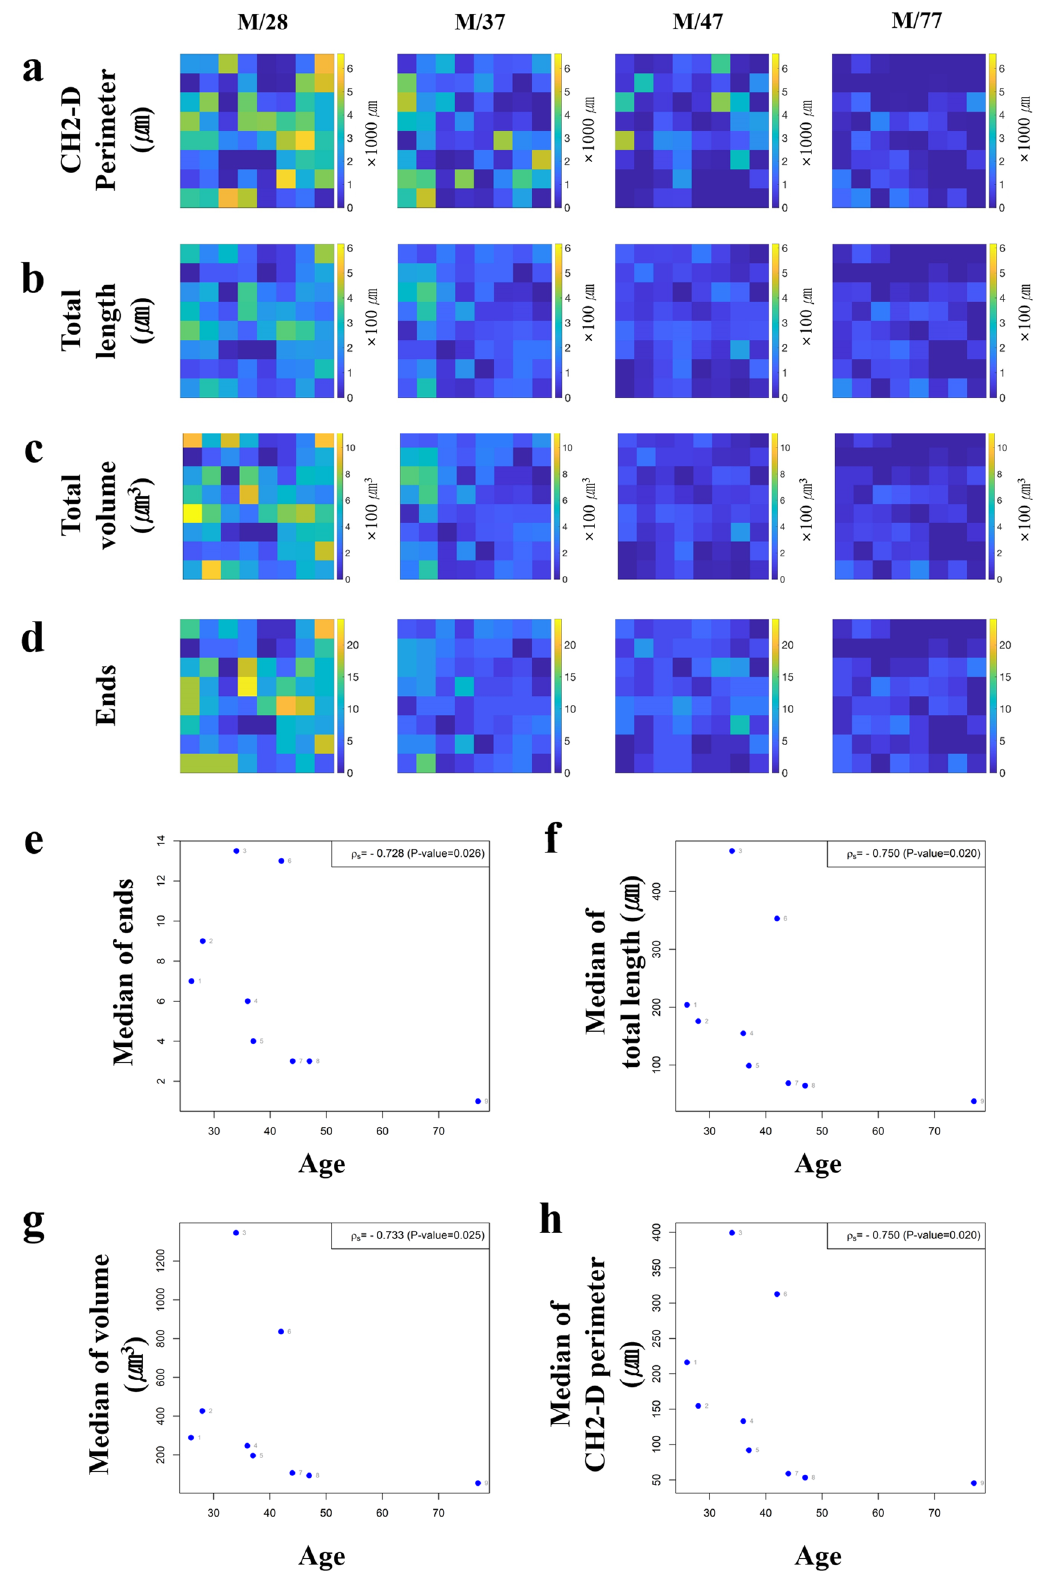
Figure 5. The graphical presentation of age-related changes in the new 3-D parameters, ( a,e ) convex hull 2-D perimeter, ( b,f ) total length, ( c,g ) volume, and ( d,h ) ends that showed the most significant correlations with natural aging. ( a–d ) Each color in 2-D color maps reflects the degree of quantified results regarding higher values as bright yellow to lower one to dark